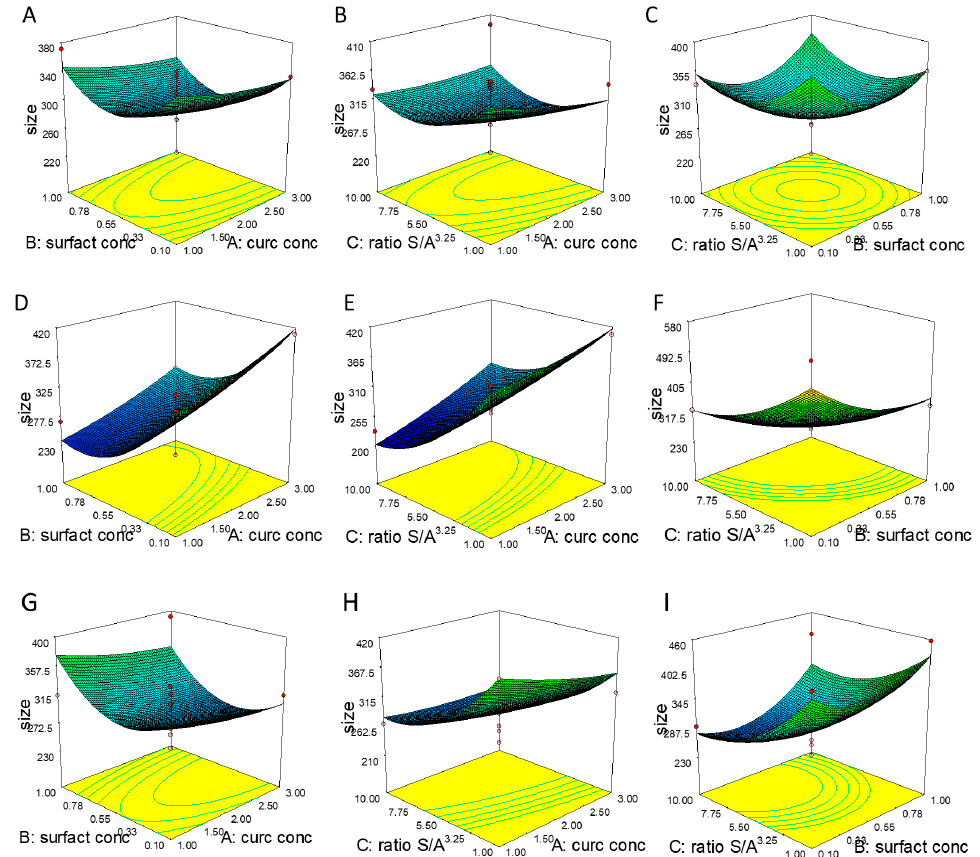
Figure 1. 3D surface of the effect of ( A ) X1 = A: curcumin concentration (mg/mL) versus X2 = B: surfactant concentration (% w/v), ( B ) X1 = A: curcumin concentration (mg/mL) versus X2 = C: solvent to antisolvent (S/A) ratio (V/V) ( C ) X1 = B: surfactant concentration (% w/v) versus X2 = C: S/A ratio (V/V), on the nanocrystals’ (NCs) size using Poloxamer 188. 3D surface of the effect of ( D ) X1 = A: curcumin concentration (mg/mL) versus X2 = B: surfactant concentration (% w/v), ( E ) X1 = A: curcumin concentration (mg/mL) versus X2 = C: S/A ratio (V/V) ( F ) X1 = B: surfactant concentration (% w/v) versus X2 = C: S/A ratio (V/V), on the NC size using PVP. 3D surface of the effect of ( G ) X1 = A: curcumin conc. (mg/mL) versus X2 = B: surfactant concentration (% w/v), ( H ) X1 = A: curcumin conc. (mg/mL) versus X2 = C: S/A ratio (V/V) ( I ) X1 = B: surfactant concentration (% w/v) versus X2 = C: S/A ratio (V/V), on the NC size using Polysorbate 80.